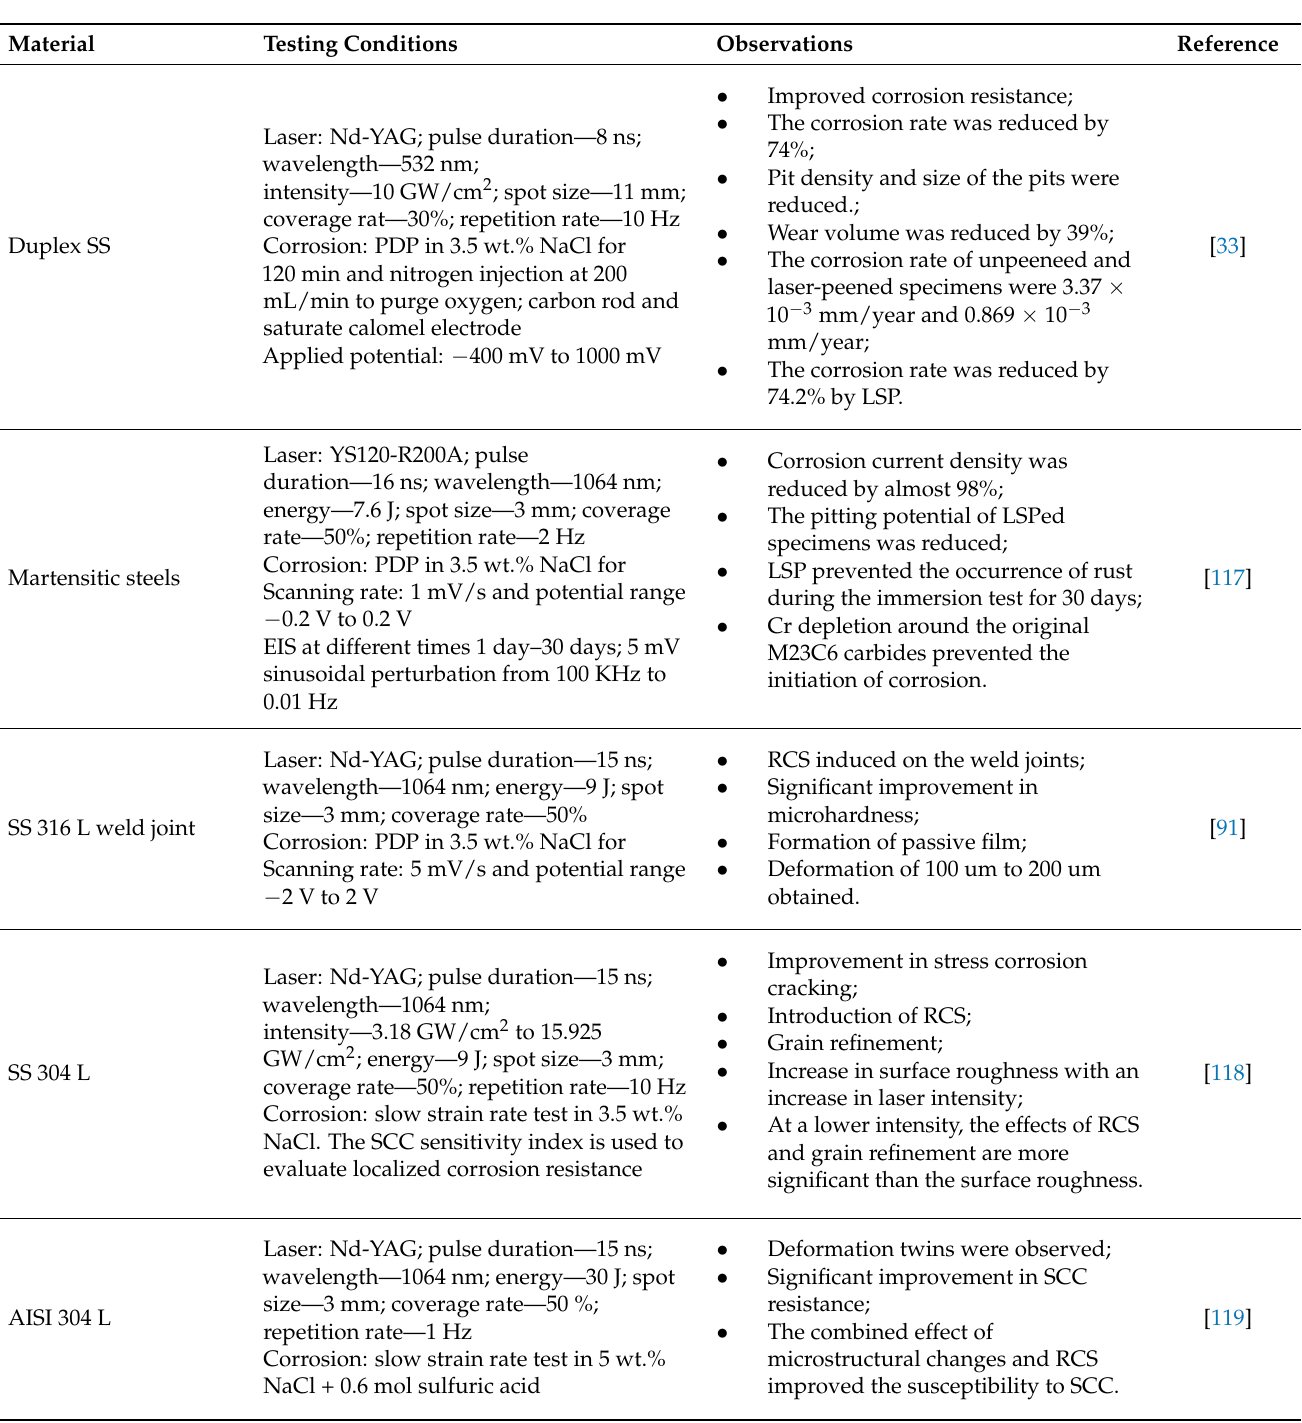
Table 3. Corrosion properties of LS’ed